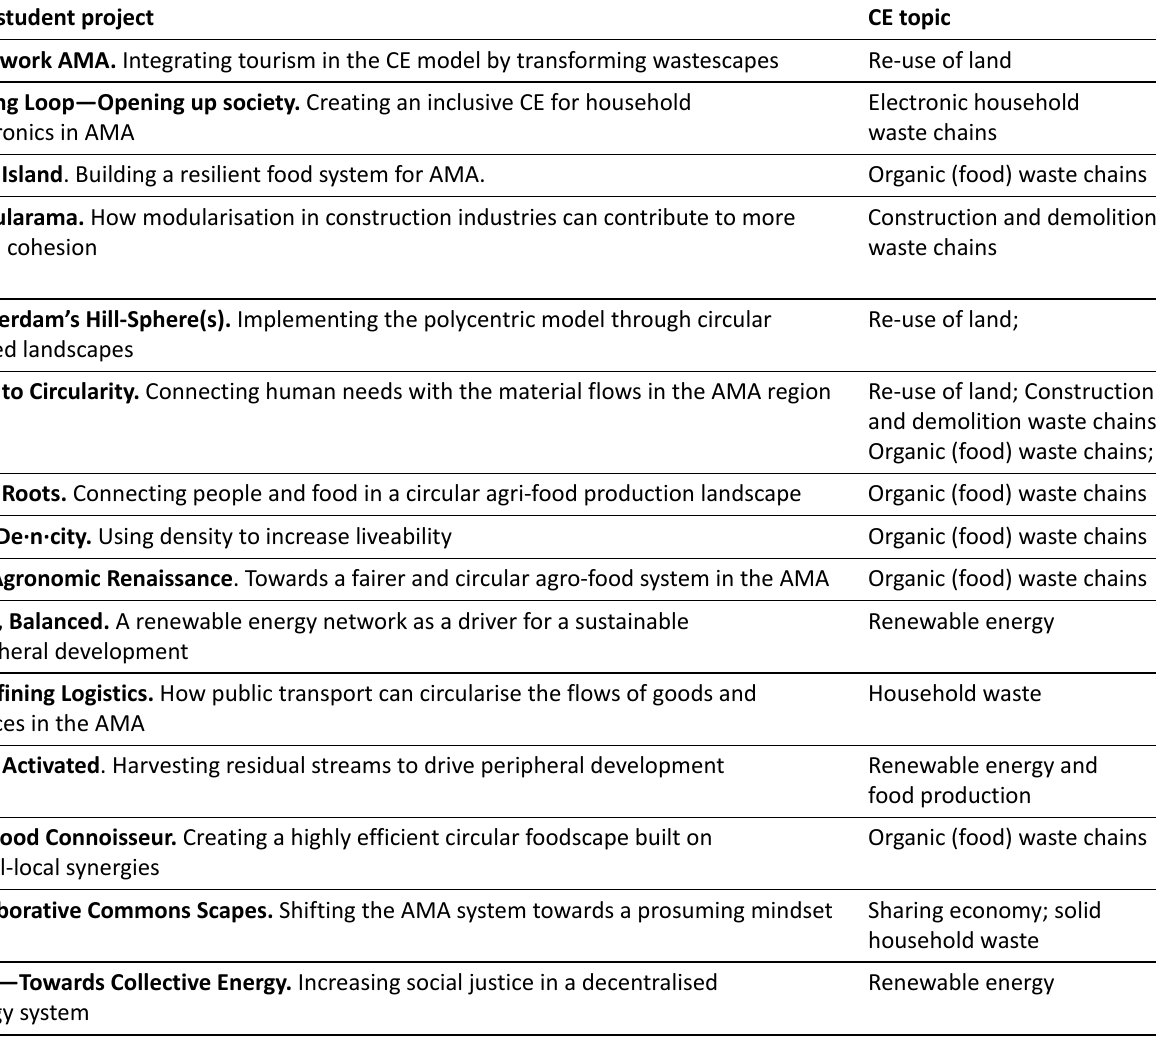
Table 1. The scope of students’